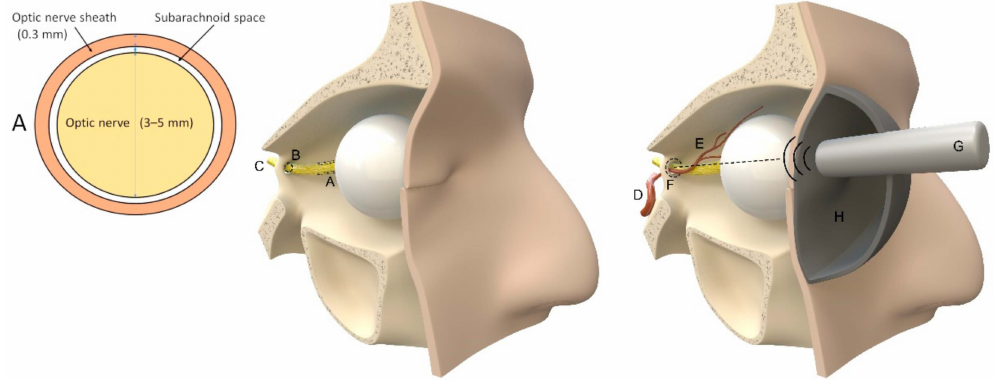
Figure 4. Ophthalmic methods. Left: schema of a coronary slice of the optic nerve 3 mm behind the globe (A); middle: illustration of intracranial (C) and extracranial (A) course of the optic nerve through the annulus of Zinn and the optic canal (B). Right: abstract illustration of ONSD and two- depth Doppler (G) measurements of intraorbital (E) and intracranial (F) ophthalmic artery branching from the internal carotid artery (D), following the descriptions of Raugaskaus with a pressure pad (H) on the eye. Illustrations were made by J.